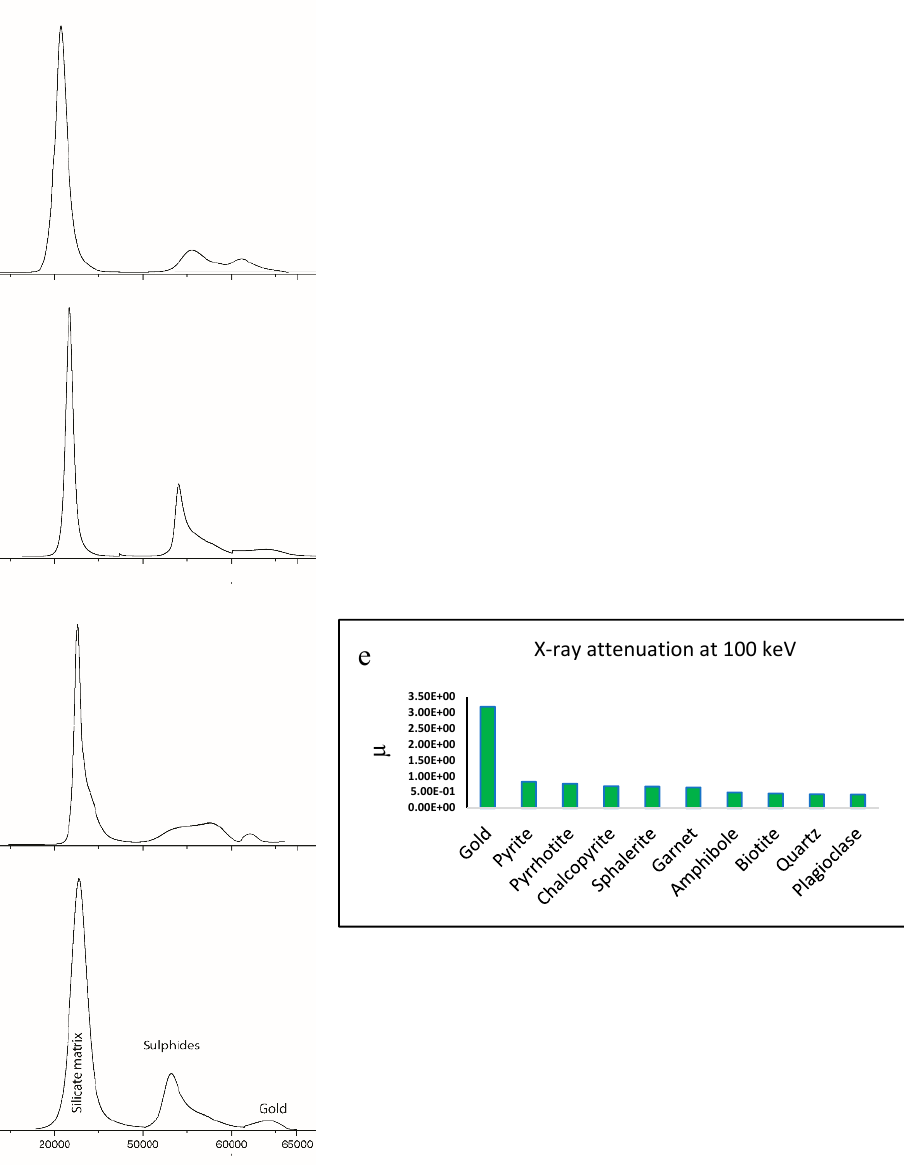
Figure 1. ( a–d ): Histograms of the core samples from grey value mapping used in thresholding. The histograms distinguish three dominant peaks. The left peak denotes the less dense bulk silicate mineral matrix, the middle peak the sulphides and the right peak denotes the much denser gold mineral. Samples JJ01, JJ02, JJ04 and JJ05, x axis denotes grey values and y axis frequency. ( e ): X-ray attenuation coefficient at 100 keV [30]. The graph indicates that at 100 KeV energy, gold will have the highest attenuation by a large margin. The XCT technique could not resolve different sulphides from one another as their density range is narrow, but clearly distinguishes gold as high atomic number phases distinct from the sulphides.